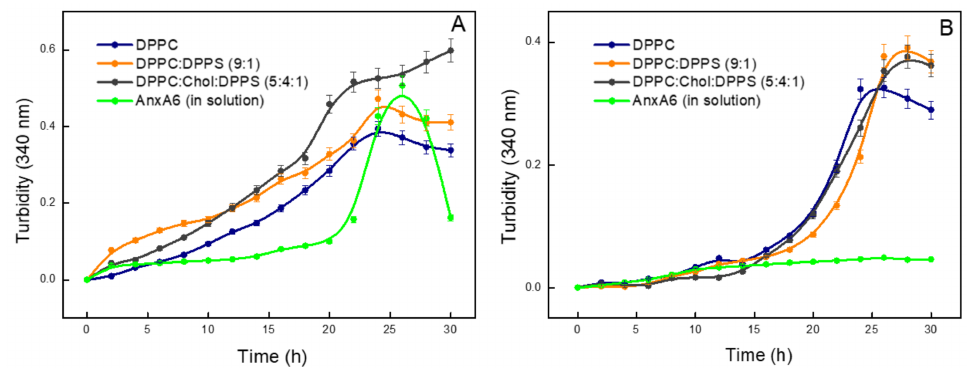
Figure 2. Mineralization curves of proteoliposomes harboring AnxA6 with PS–CPLX nucleator. ( A ) Absence of type-I collagen; ( B ) presence of type-I collagen. Change with time of the value of absorbance at 340 nm of different compositions of proteoliposomes harboring AnxA6. Blue—DPPC; Orange—9:1 DPPC:DPPS; Black—5:4:1 DPPC:Chol:DPPS; and Green—Control: AnxA6 in solution. When AnxA6 was mixed with PS–CPLX and each of the liposomes (DPPC, DPPC:DPPS (9:1), or DPPC:Chol:DPPS (5:4:1)), two simultaneous processes could be identified: (1)